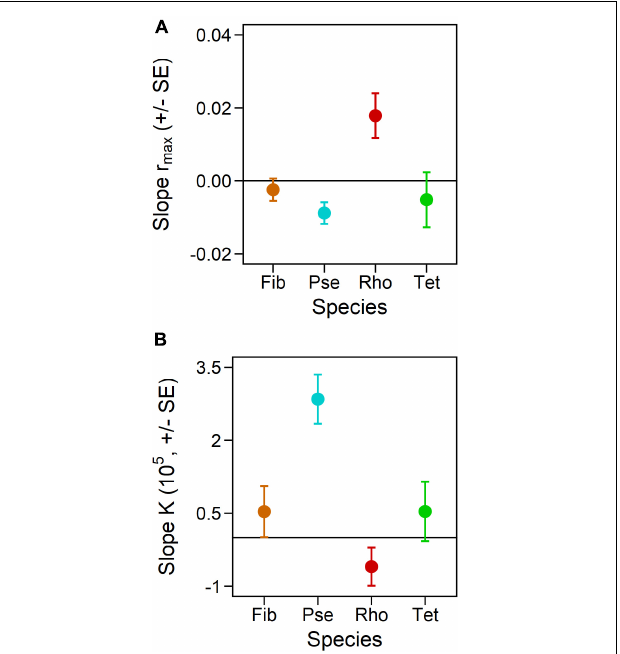
FIGURE 4 | Slopes from the relations between fluctuation frequency and responses in maximum growth rates (A) and carrying capacities (B) of the monocultures, calculated based on linear regressions. A positive correlation indicates a higher r max or K, respectively, with higher fluctuation frequency, i.e., the faster the light color fluctuated. Error bars represent standard error of calculated regression